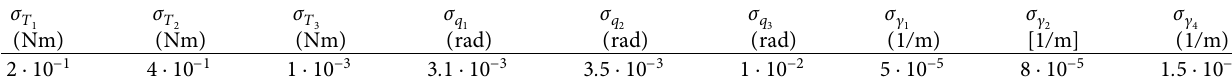
Table 3: Standard deviations assumed for each measurement